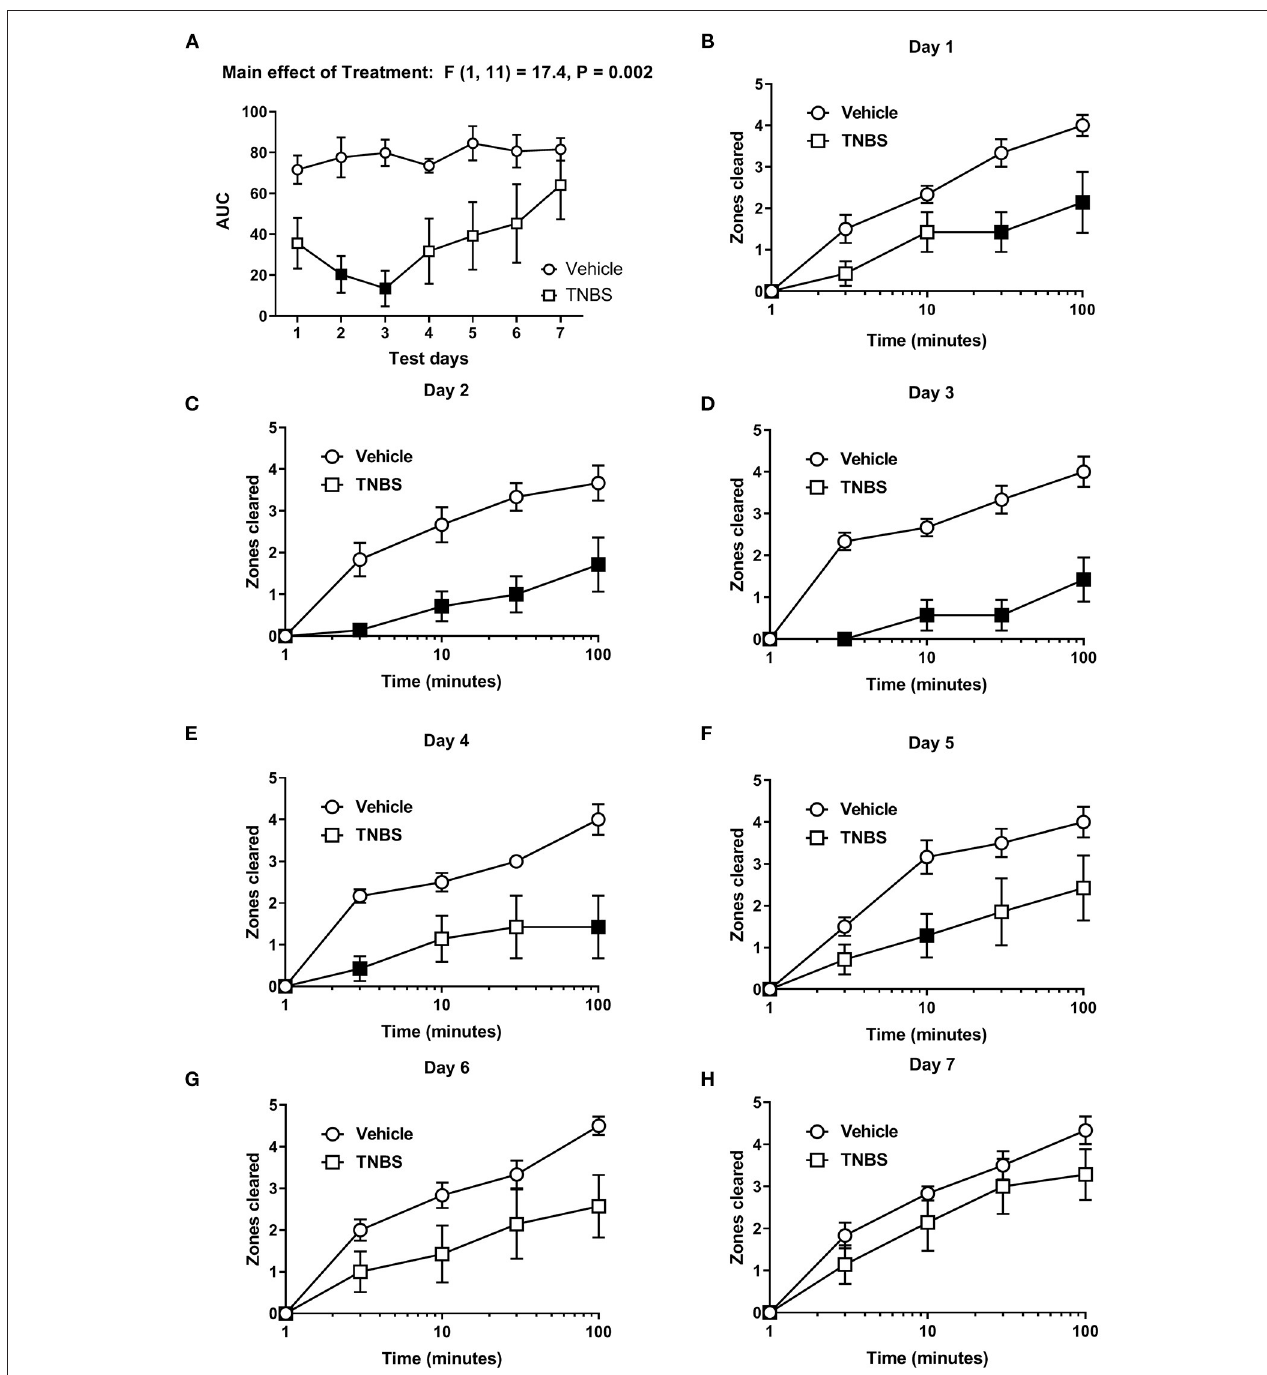
FIGURE 2 | Effect of TNBS on nesting behavior. (A) The area under the curve (AUC) of nesting scores recorded daily in mice treated with vehicle or TNBS. (B–H) show zones cleared at 3, 10, 30, and 100min in mice treated with vehicle or TNBS on Days 1–7, respectively. TNBS treatment transiently depressed nesting that peaked on Day 3 but was not apparent on Day 7. Filled points represent statistical significance ( P < 0.05) vs. vehicle as indicated by a significant treatment effect in the two-way repeated measures ANOVA with Bonferroni’s test. Data are mean ± SEM. Vehicle ( N = 6/day); TNBS ( N = 7/day).